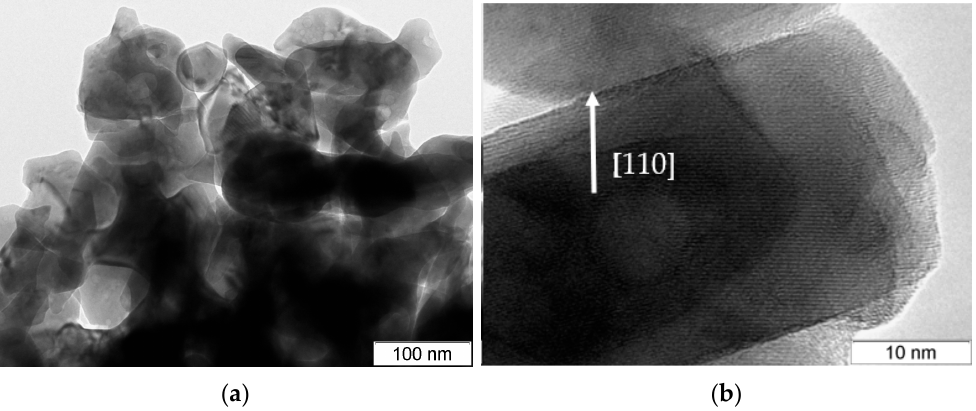
Figure 3. HRTEM images of morphology ( a ) and crystal lattice ( b ) of the LaMn 0.6 Fe 0.4 O 3 sample after methane oxidation.